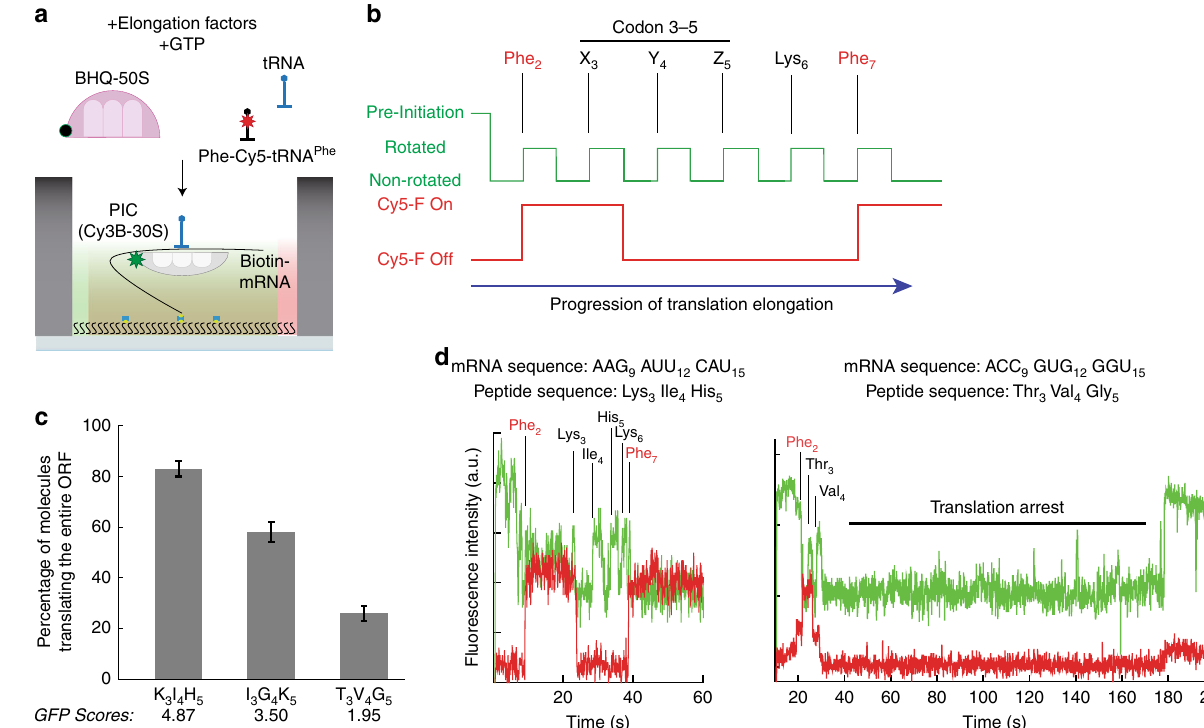
Fig. 7 smFRET assay for monitoring translation of codon 3 – 5. a Schematics of zero-mode waveguide (ZMW)-based single-molecule FRET assay to monitor translation. Elongation factors including fl uorescently-labeled tRNA (Phe-(Cy5)-tRNA Phe ) and quencher-labeled large ribosomal subunit (BHQ- 50S) are delivered to pre-initiation complex (PIC) with labeled small ribosomal subunit (Cy3B-30S) and mRNA tethered to the ZMWs. b Expected fl uorescence signal observed from a translating complex utilizing FRET between Cy3B and BHQ-2 on ribosomal subunits, as well as direct excitation of Cy5 on Phe-(Cy5)-tRNA Phe . c Measured percentage of complete translation events for different codon 3 – 5 mRNA constructs ( n = 179 molecules for all; error bars represent s.e. based on the binomial distribution). d Representative traces for “ processive ” translation of K 3 I 4 H 5 (Left) and “ abortive ” translation of T 3 V 4 G 5